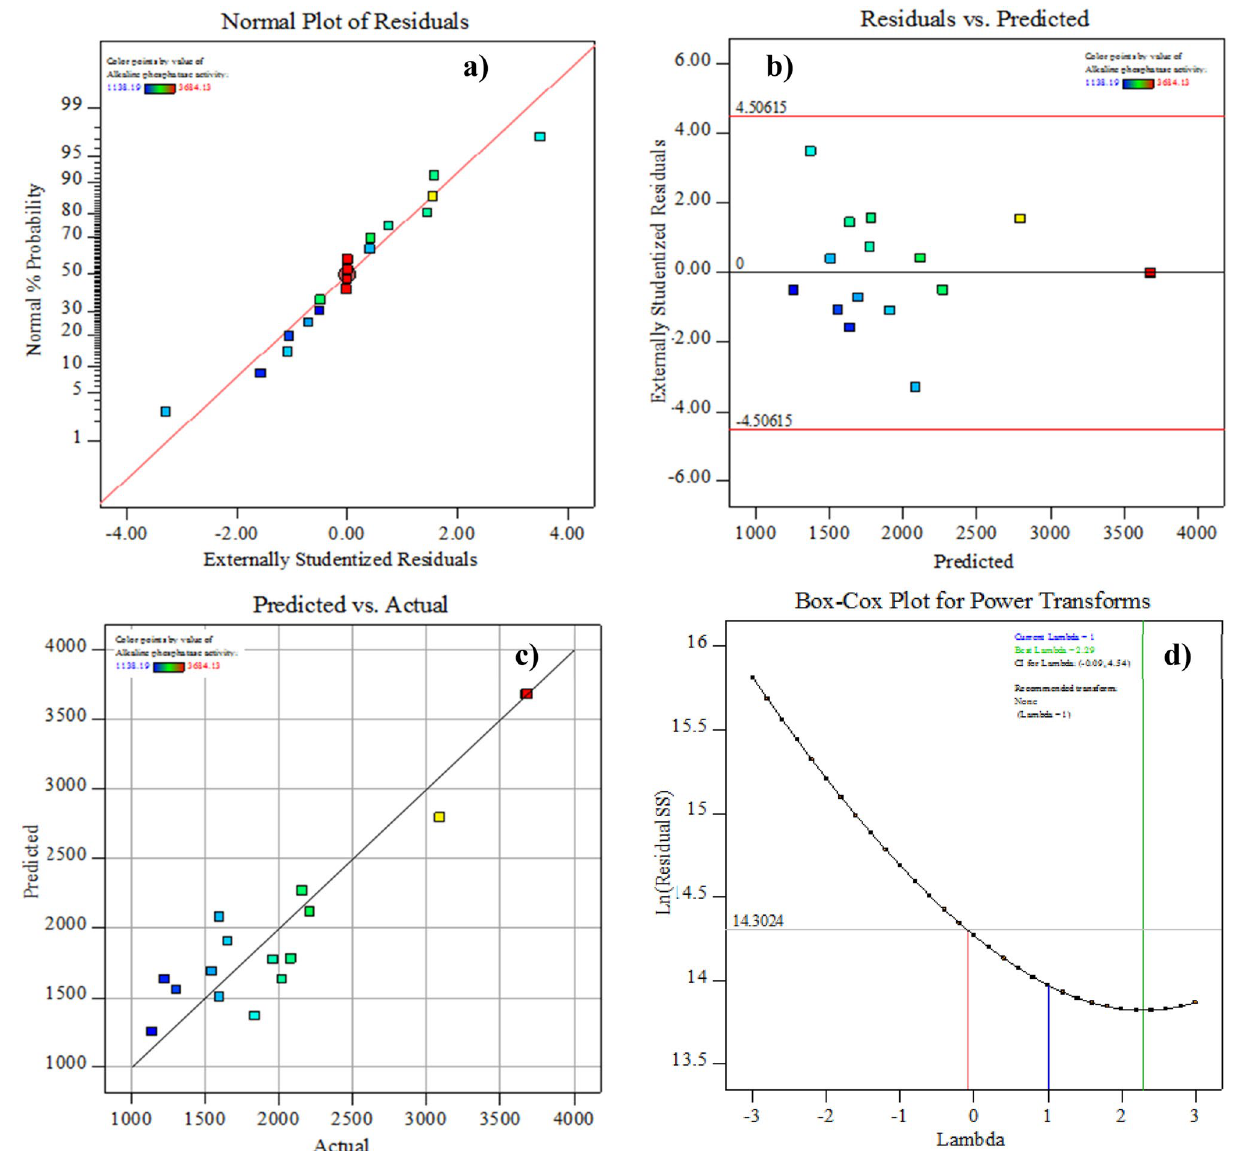
Figure 4. Model adequacy checking of the rotatable central composite design (RCCD): ( a ) normal probability plot of internally studentized residuals, ( b ) internally studentized residuals versus predicted ALP production, ( c ) plot of predicted versus actual ALP production, and d) Box-Cox plot of model